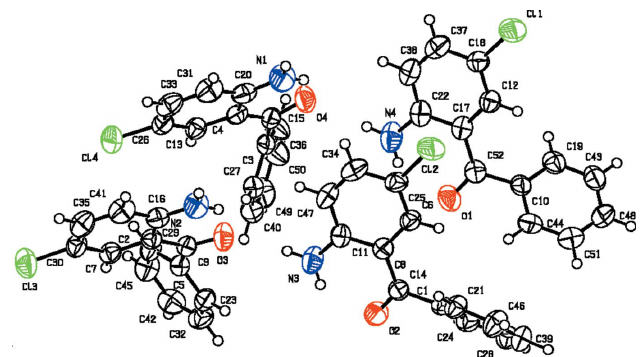
Figure 1 The four independent molecules in the asymmetric unit of the title compound showing the atom labelling scheme and 50% probability displacement